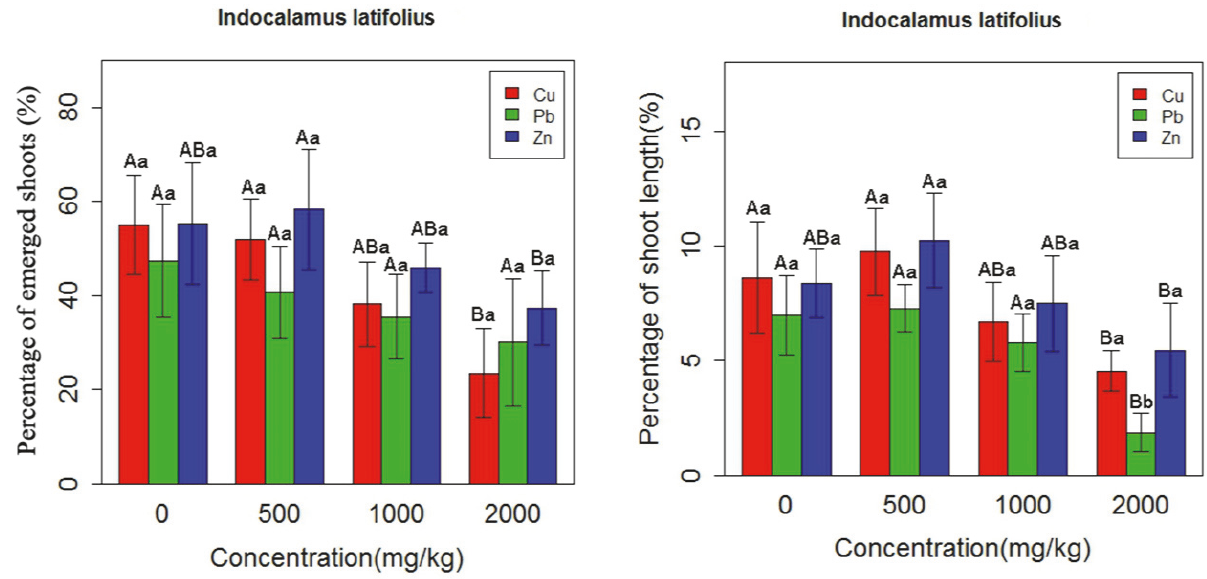
Figure 1: Effects of HMs on growth indices of Indocalamus latifolius . The capital letters are the demonstration of statistical significance between different heavy metals across various concentrations and the small letters are the demonstration of statistical significance between heavy metals in each concentration. Vertical bars represent ± SD